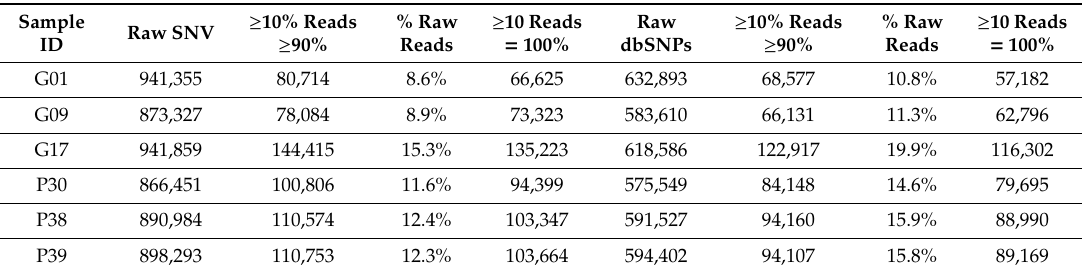
Table 2. Analysis of filtered and trimmed dbSNPs in boar spermatozoa using variant calling of RNA-Seq